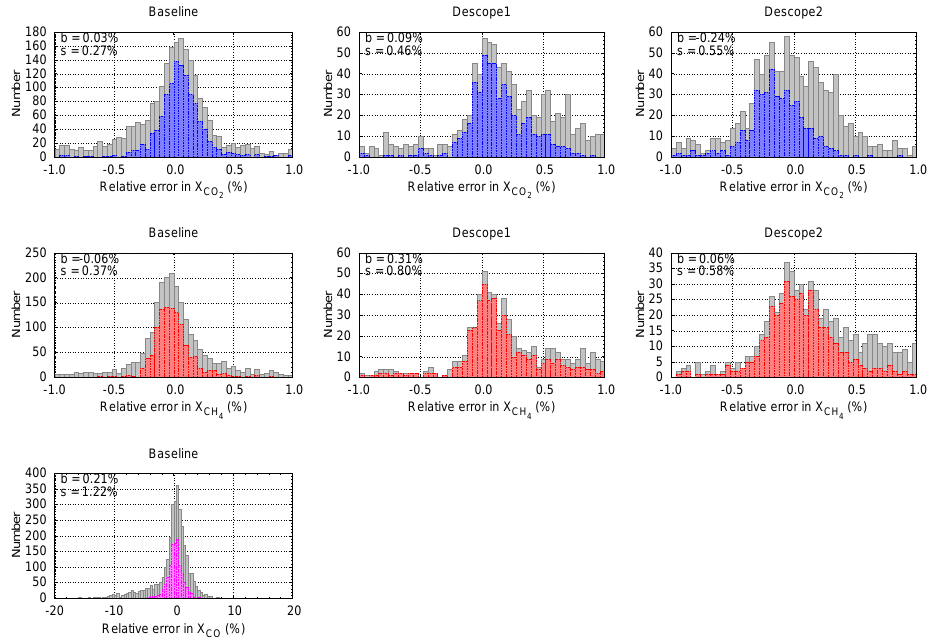
Fig. 13. Histograms of errors in retrieved X CO , X CH and X CO for the baseline and descope configurations when the priors assumed for 2 4 both the vertical profiles of CO 2 , CH 4 , CO and meteorology coincide with the truth. The biases ( b ) and standard deviations ( s ) quoted are for the histograms after the post-processing filters have been applied.